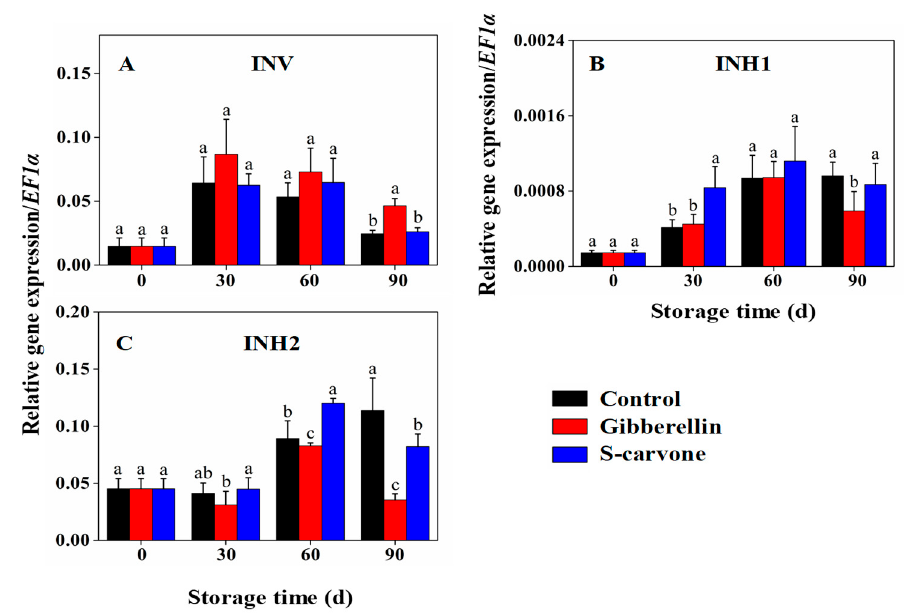
Figure 8. Effects of gibberellin and ( S )-carvone on gene expression/ EF1a in potato tubers during 4°C low temperature storage. ( A ) Gibberellin and ( S )-carvone effect on expression of INV . ( B ) Gibberellin and ( S )-carvone effect on expression of INH1 . ( C ) Gibberellin and ( S )-carvone effect on expression of INH2 . The error bars represent the standard errors. Means with the same letters are not statistically different according to the least significant difference test at p < 0.05.